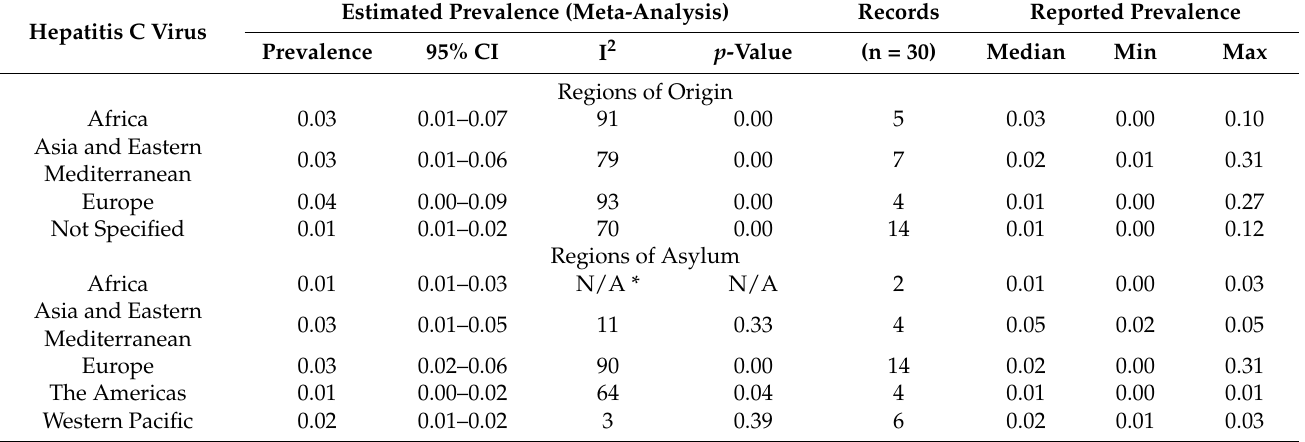
Table 5. Hepatitis C virus prevalence estimates, 95% confidence interval, heterogeneity level (I 2 ), p -value, records, median, minimum, and maximum reported prevalence among refugees and asylum